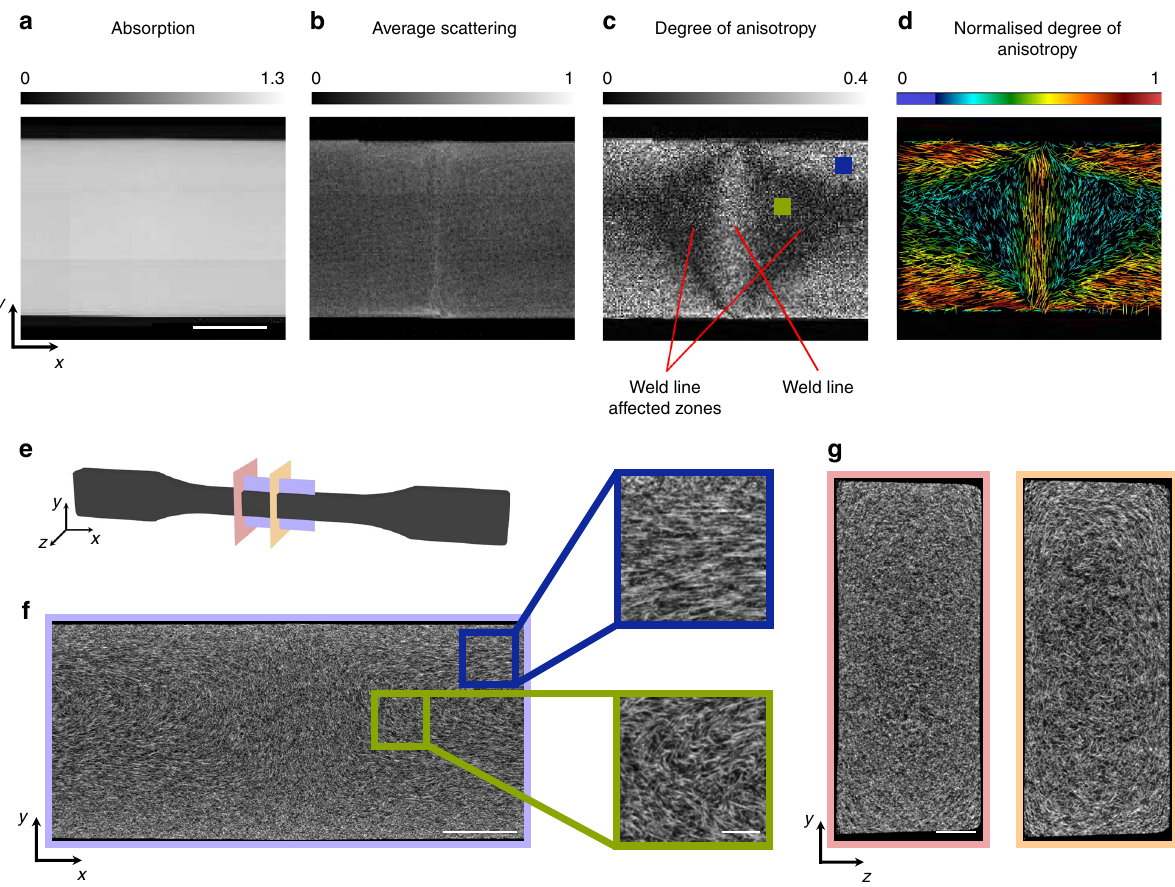
Fig. 3 Correlative investigation of weld line. a Absorption, b average scattering, c degree of anisotropy, and d retrieved projected fi bre orientation images of the weld line (scale bar: 5 mm). In order to validate the observed results, a high resolution tomographic scan was performed around the centre of the tensile sample where the weld line is located. The location of the investigated tomographic slices are shown in ( e ). In the coronal slice ( f ) the asymmetry of the weld line which is observed in the degree of anisotropy image ( c ) can be justi fi ed (scale bar: 2.7 mm). The zoom-ins (scale bar: 400 μ m ) highlight areas of low and high fi bre alignment which correlate well with similar areas in the degree of anisotropy image marked by blue and green squares, respectively. The sagittal slices ( g ) show the difference between the weld line affected and non-areas of the sample as the fi bre orientation changes from out of plane to in plane (scale bar: 1 mm